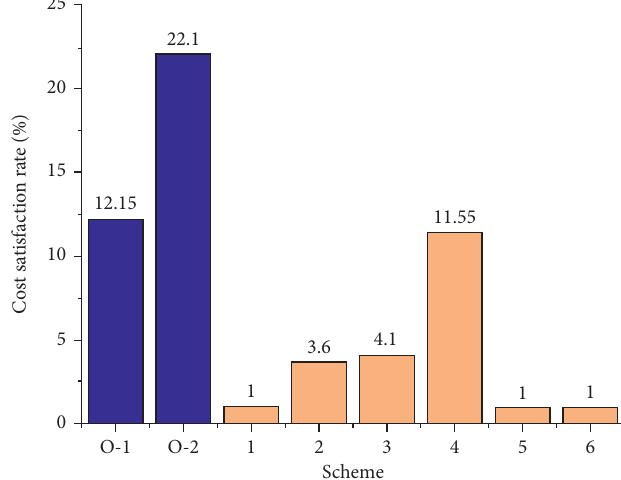
Figure 8: Statistical chart of cost satisfaction